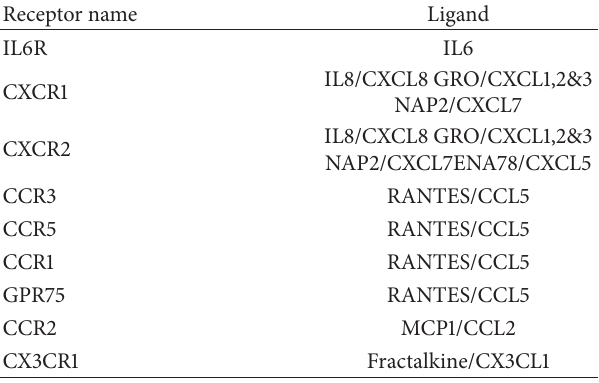
Table 2: Cytokines/chemokines receptors name and its